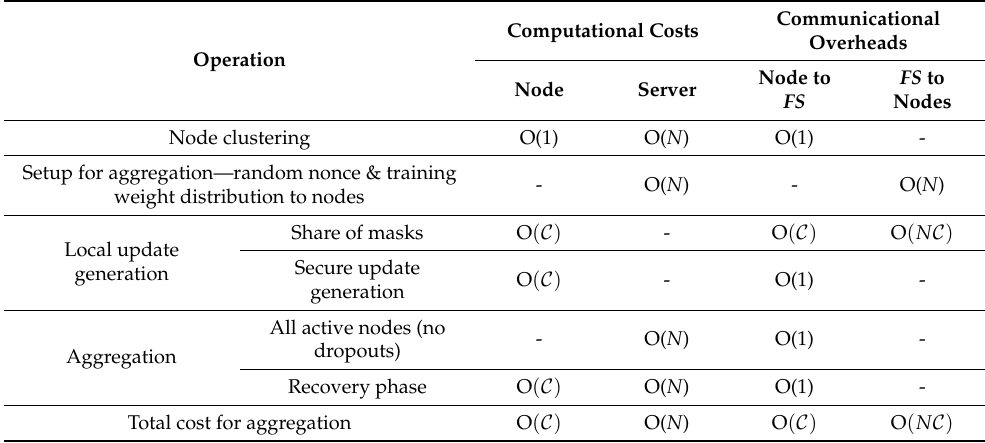
Table 2. Computational costs and communicational overheads of FCSA .